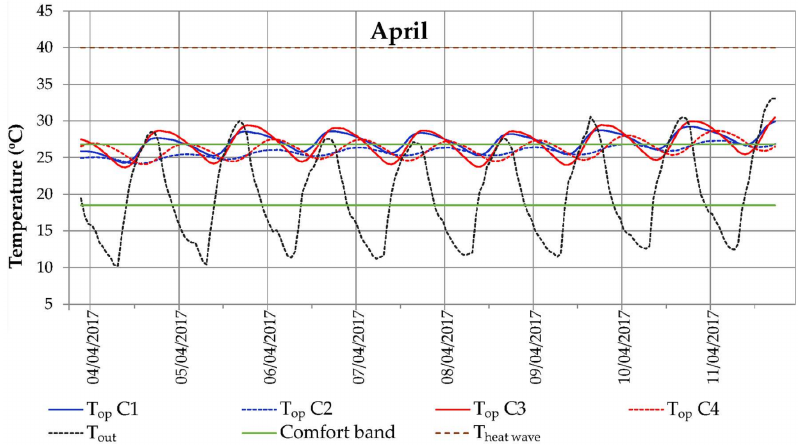
Figure 5. April protocol (no ventilation): Daily evolution of operative temperatures in each cell compared to outdoor temperatures (see Supplementary Materials Figure S1a).